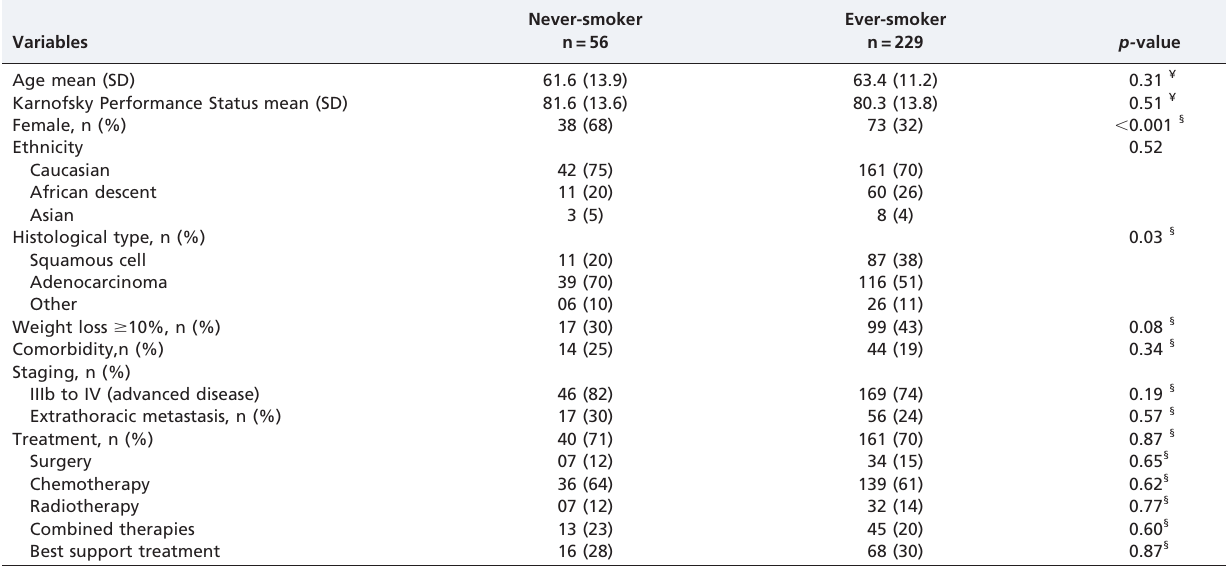
Table 1 - Characteristics of NSCLC patients grouped according to their smoking status at diagnosis.